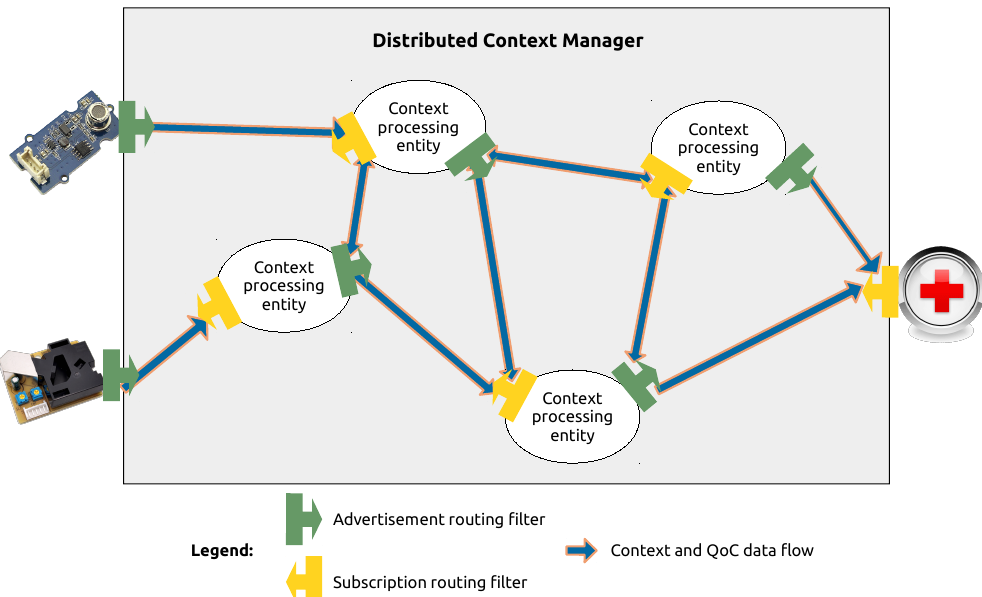
Figure 7. Overview of the routing filters within a distributed context manager.